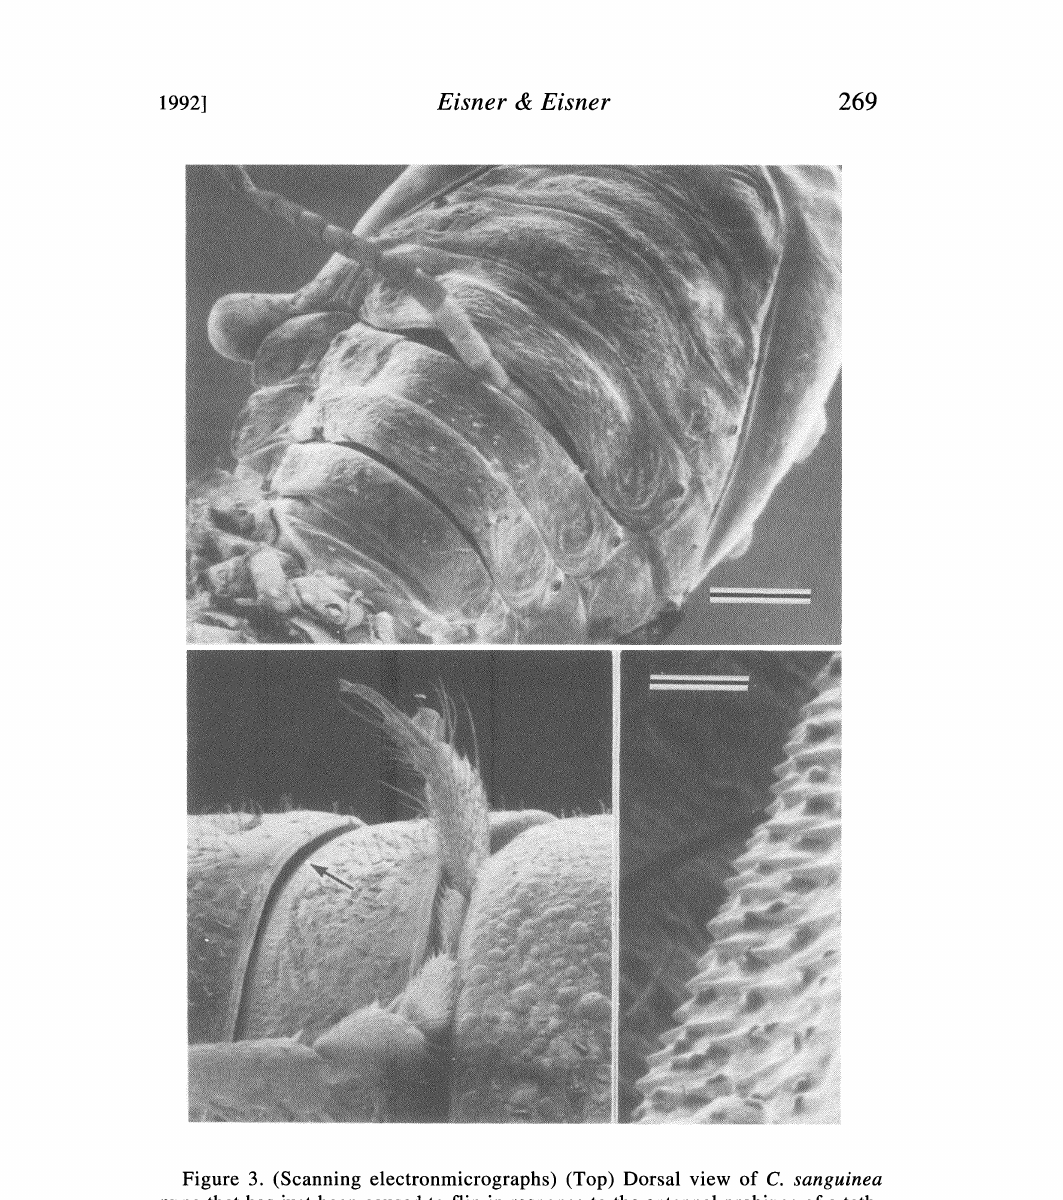
Figure 3. (Scanning electronmicrographs) (Top) Dorsal view of C. sanguinea pupa that has just been caused to flip in response to the antennal probings of a teth- ered ant. An antenna of the ant is seen caught in the squeeze of the anteriormost gin trap. (Bottom left) Comparable to preceding, showing a leg of an ant being pinched by a trap. (Bottom right) Detail of margin of anterior "jaw" of a gin trap (region denoted by arrow in picture on left), showing the typical serration. Reference bars: top 0.5 mm; bottom right